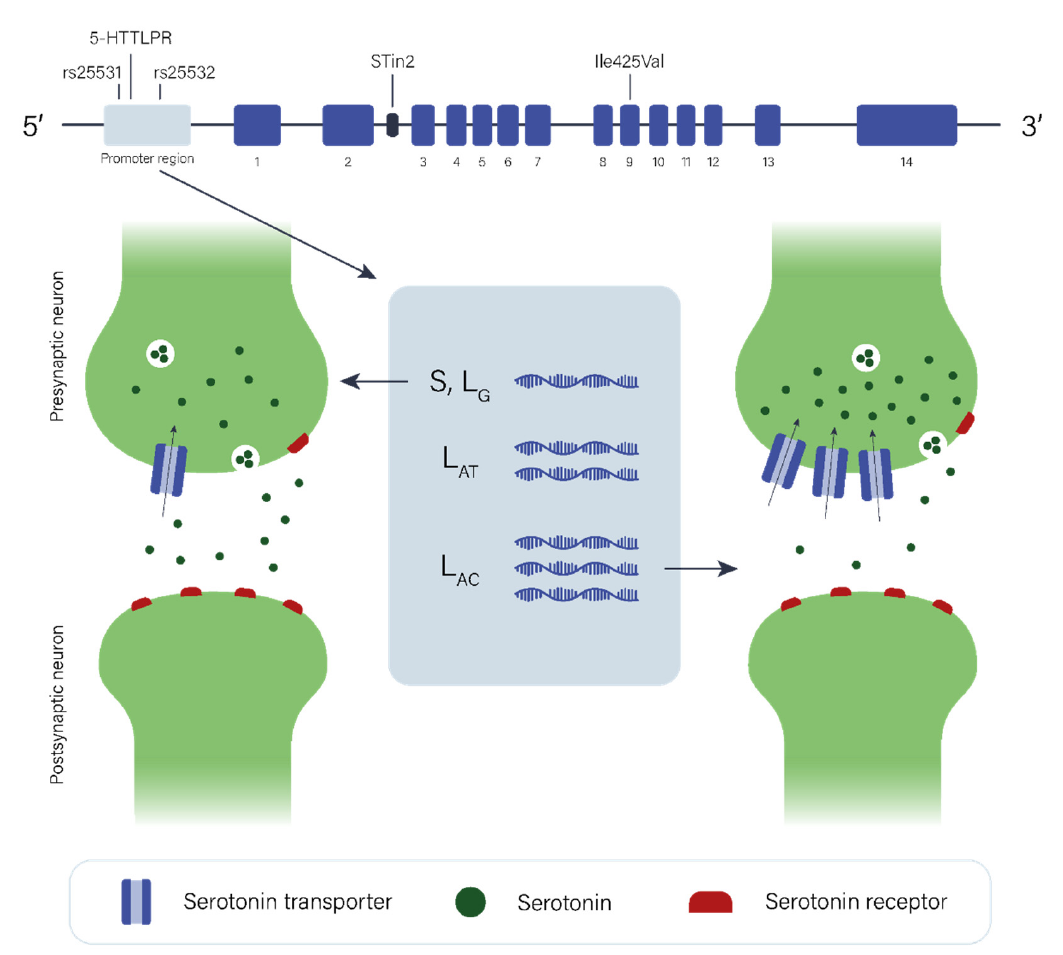
Figure 2. SLC6A4 and serotonergic neurotransmission. SLC6A4 gene, exon numbers, and the polymorphisms 5-HTTLPR, rs25531, rs25532, STin2, and Ile425Val in the top part of the figure. The different 5-HTTLPR/rs25531/rs25532 three-locus haplotypes ( bottom middle ) are likely to affect SLC6A4 mRNA expression ( bottom middle ). It is hypothesized that S and L G haplotypes result in low SLC6A4 mRNA expression ( bottom left ), while the L AC haplotype results in SLC6A4 overexpression, leading to increased SERT in the presynaptic neuron followed by increased serotonin clearance from the synaptic cleft ( bottom right ). 5-HTTLPR: SERT-linked polymorphic region; S: short allele of 5-HTTLPR; L G : long allele of 5-HTTLPR and minor allele of rs25531; L AT and L AC : 5-HTTLPR/rs25531/rs25532 three-locus haplotypes, differing in rs25532 alleles.